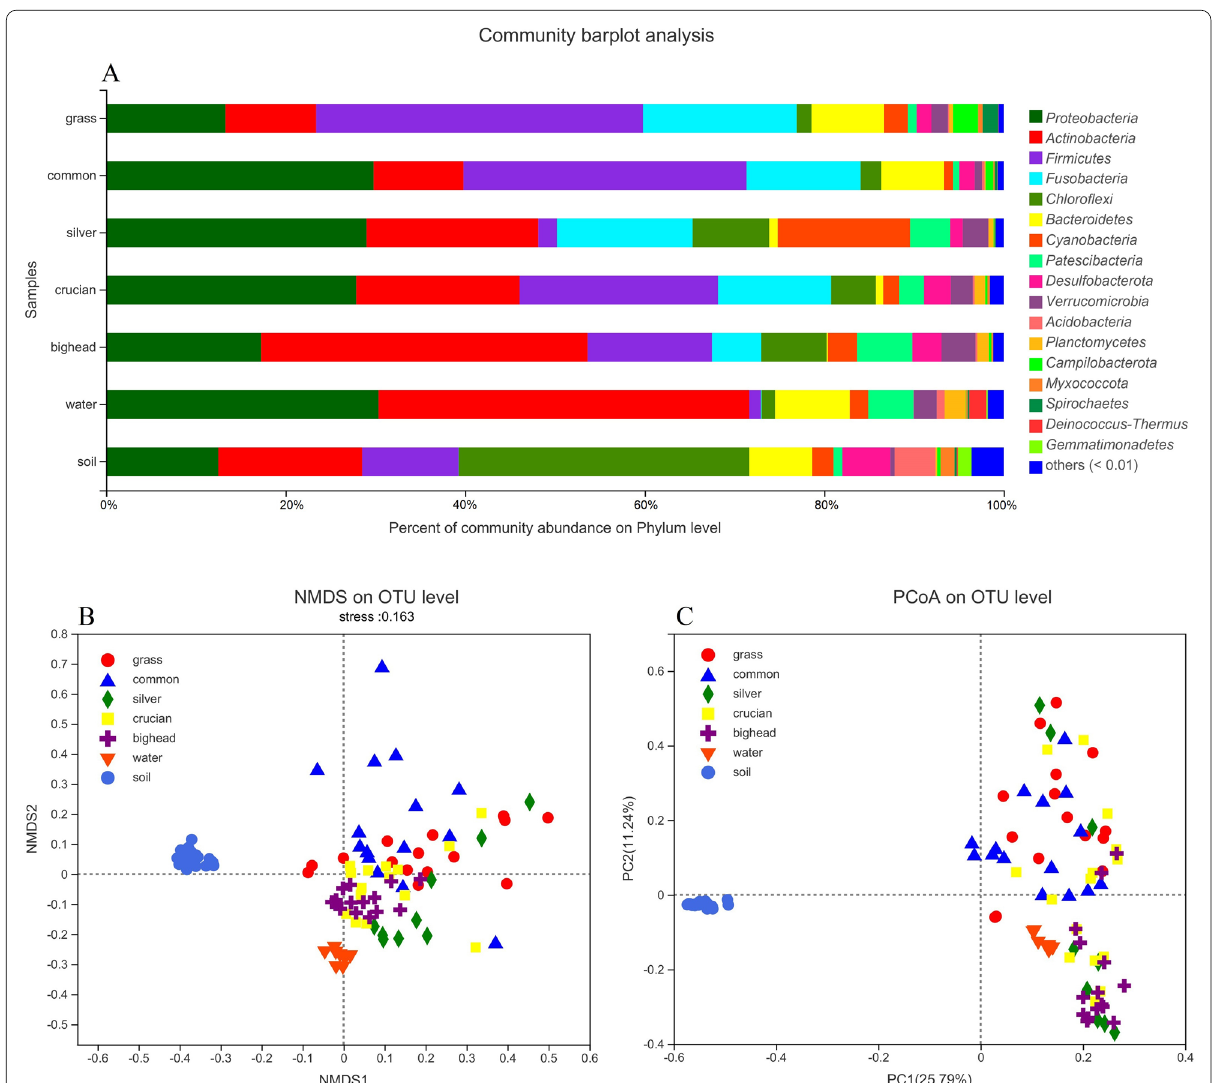
Fig. 1 A Bacterial community structure at the phylum level for sample groups. Non-metric multidimensional scaling analysis B and principal co-ordinates analysis C revealed significant variations between intestinal and soil bacterial communities. Grass, common, silver, crucian, and bighead indicating intestinal bacterial communities in the five analyzed carp species; water and soil indicating planktonic and soil bacterial